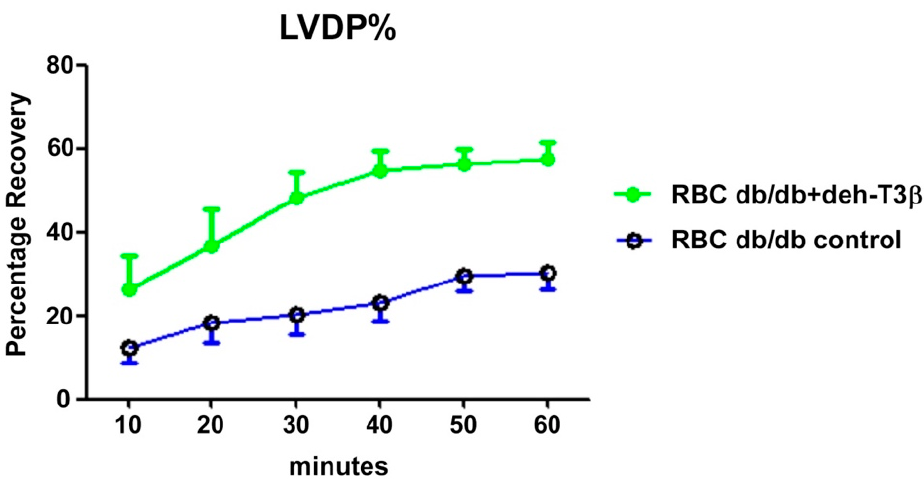
Figure 9. db/db mice were fed with deh-T3 β mixed in the diet or standard chow (for the control group) for one month. Blood from these mice was used to study the non-diabetic C57B6 mouse heart response to ischemic reperfusion injury for 40 min.